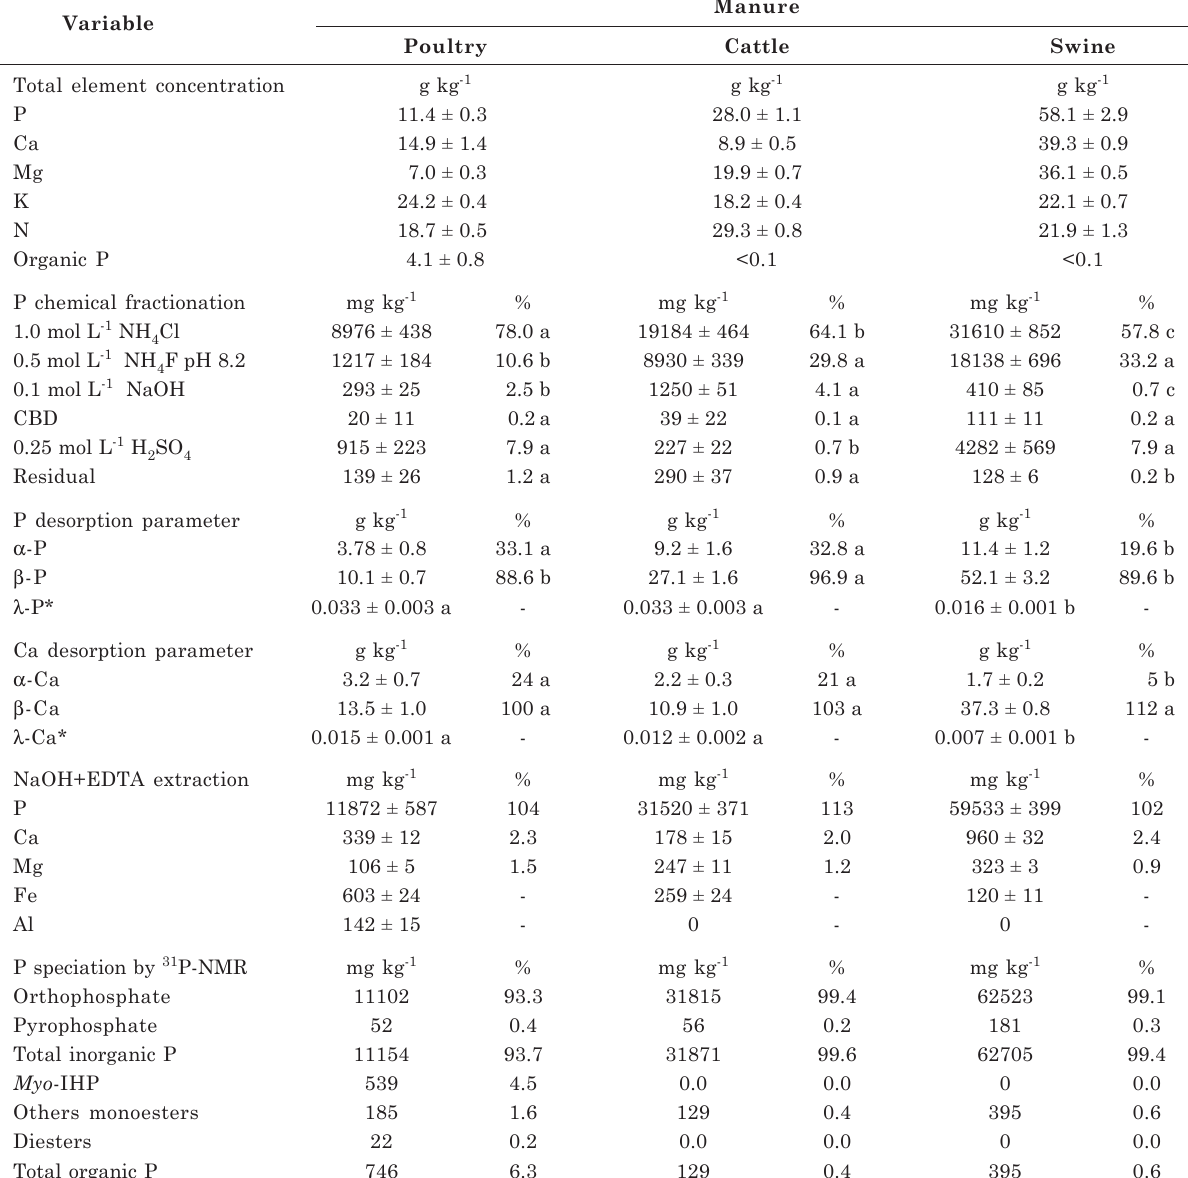
Table 2. Selected chemical characteristics, sequential chemical P fractionation, P and Ca desorption kinetic parameters and organic P molecular species determined by 31 P nuclear magnetic resonance spectroscopy in three manure